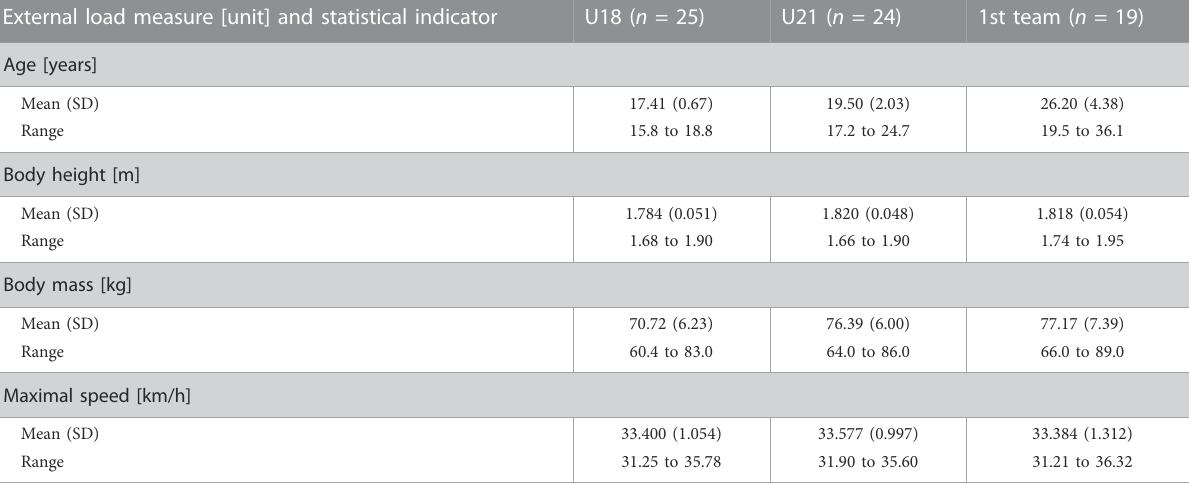
TABLE 1 Descriptive statistics of the participant ’ s age, body height, body mass and maximal speed. Data presented as mean (SD) and range. External load measure [unit] and statistical